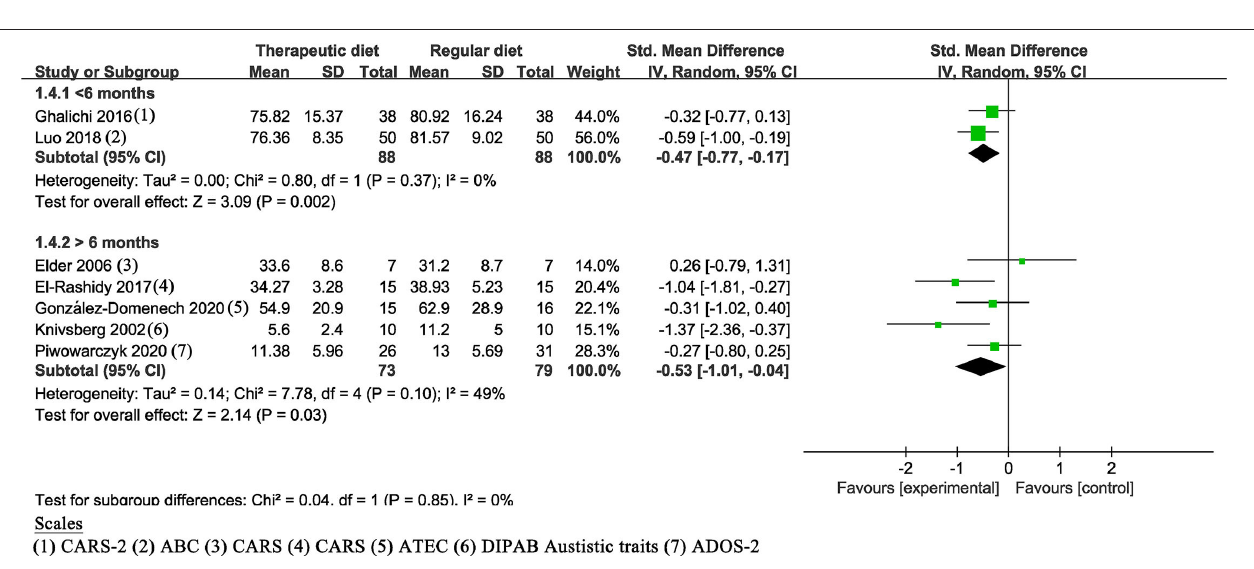
FIGURE 5 | Meta-analysis results and scales for the duration. GARS (-2), Gilliam Autism Rating Scale (Second Edition); ABC, Autism children behavior checklist; ATEC, Autism Treatment Evaluation Checklist; DIPAB, a standardized Danish scheme to evaluate behavior; ADOS-2, Autism Diagnostic Observation Schedule, Second